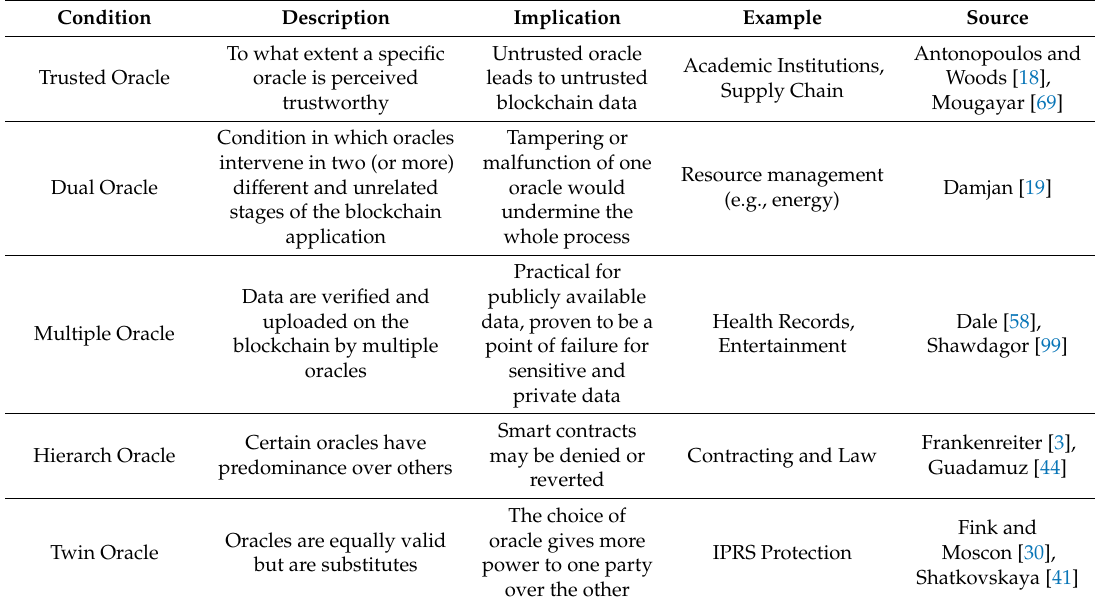
Table 1. Oracle problem: conditions and